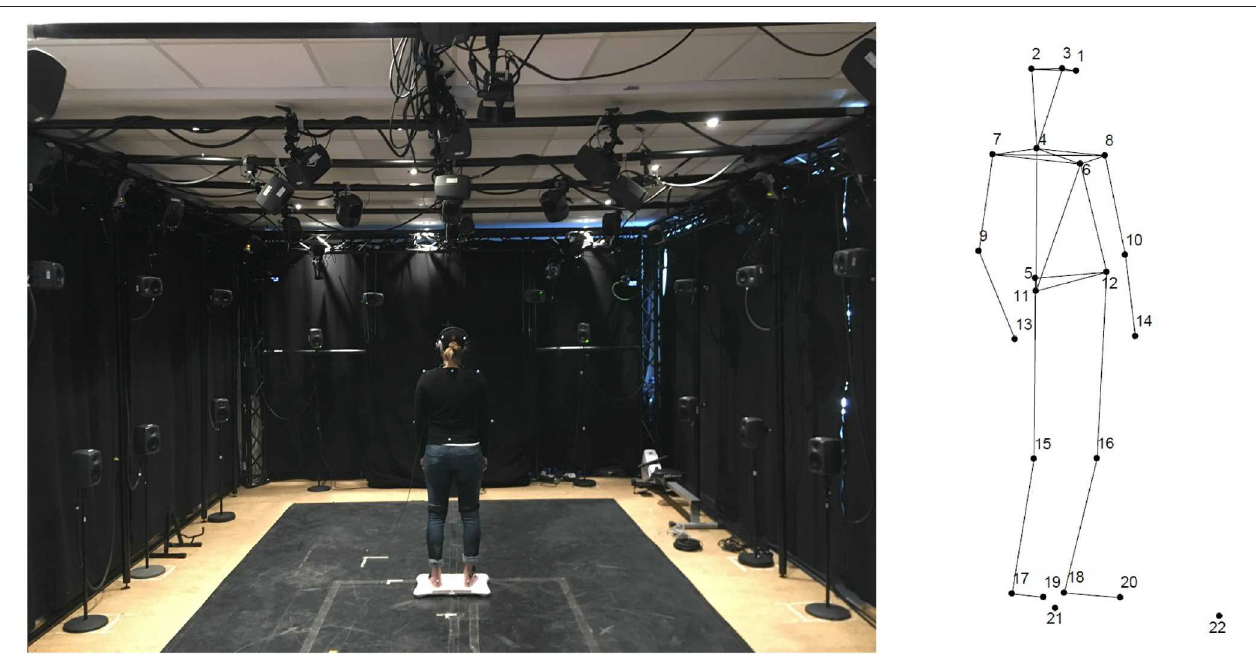
FIGURE 3 | (Left) Laboratory setup and one participant standing during the headphones condition. Written informed consent was obtained from the participant for publication of images. (Right) Motion capture reconstructed markers and segments. The markers were located as follows (L, left; R, right; F, front; B, back): 1—F head; 2—RB head; 3—LB head; 4—B neck; 5—sacrum; 6—sternum; 7—R shoulder; 8—L shoulder; 9—R elbow; 10—L elbow; 11—R hip; 12—L hip; 13—R wrist; 14—L wrist; 15—R knee; 16—L knee; 17—R heel; 18—L heel; 19—R toe; 20—L toe; 21—reference marker on the Wii board; 22—reference marker on the